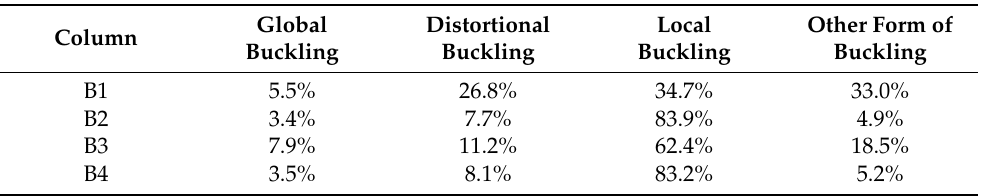
Table 8. Values of critical stresses and critical forces obtained from numerical simulations per- Table 9. Percentage contribution of individual buckling forms to the loss of stability of the formed with the finite strip method. tested columns. Column